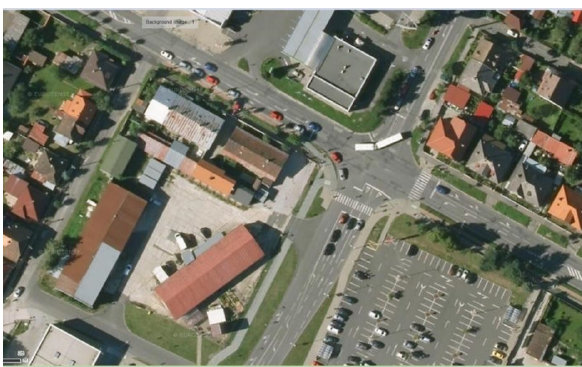
Figure 1: Satellite view of the intersection